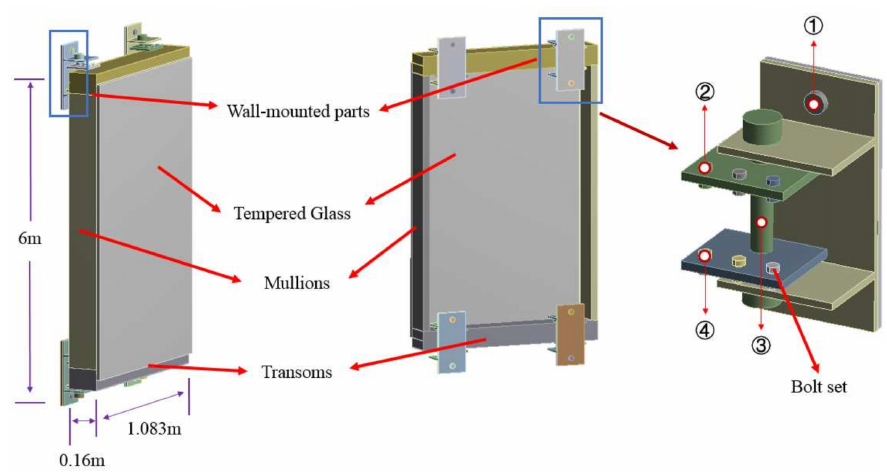
Figure 5. Schematic diagram of glass curtain wall structure and nodes. 1–4 are the selected represen- tative